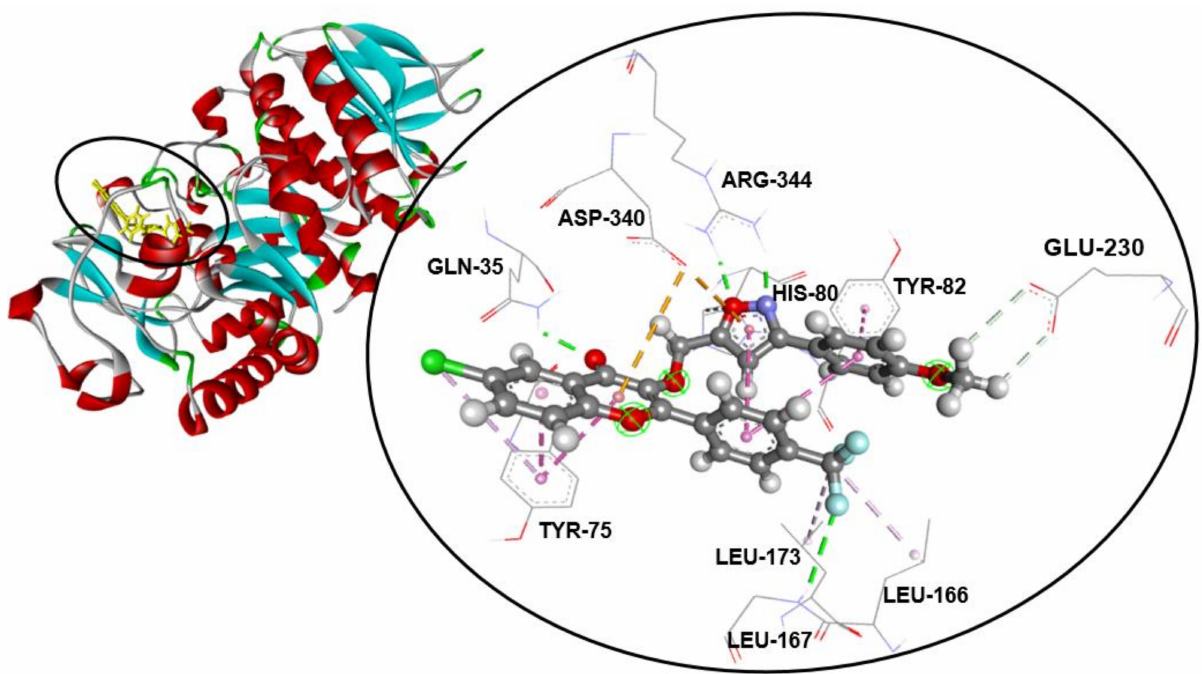
Figure 2. Compound 3h fits into the hydrophobic binding pocket of ABC in PDB: